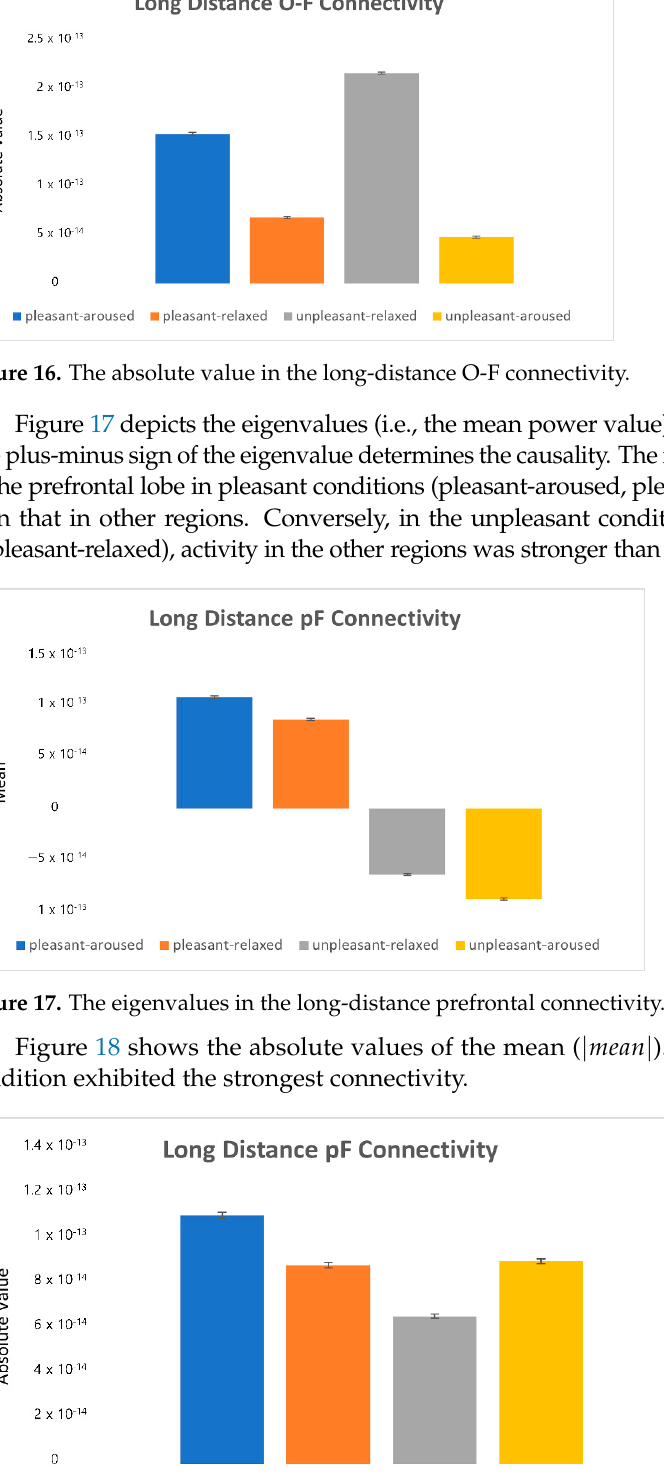
Figure 15. The eigenvalues in the long-distance O-F connectivity.